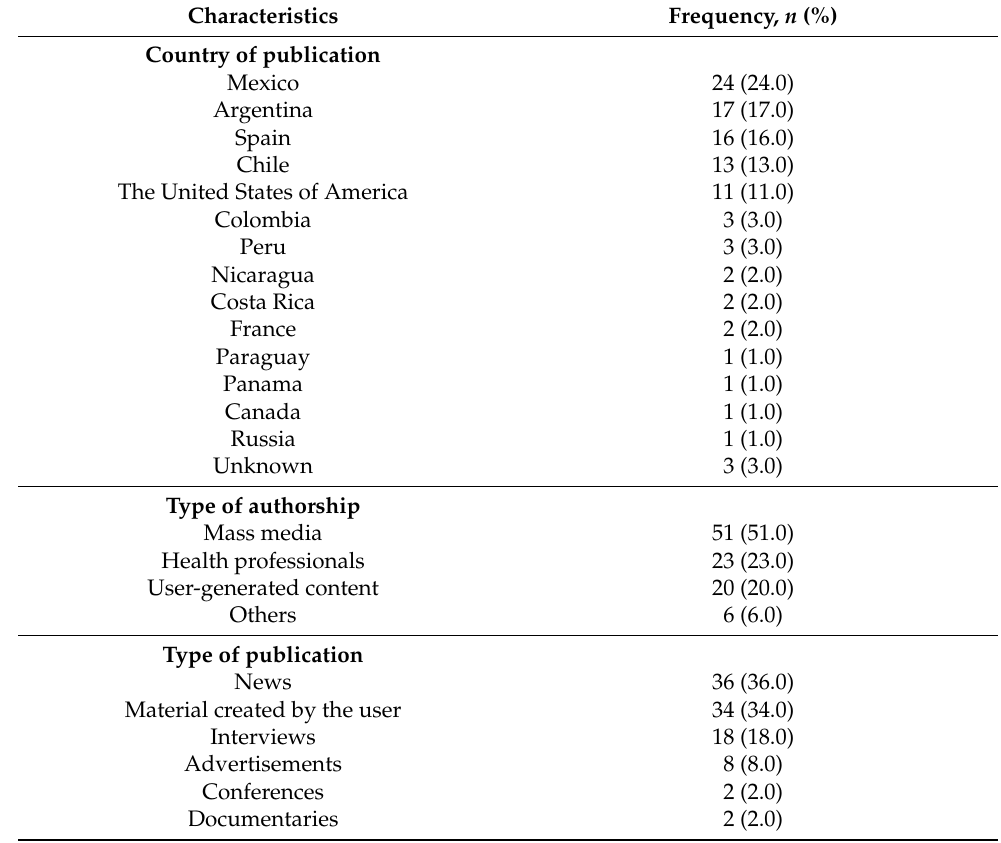
Table 1. General characteristics of the 100